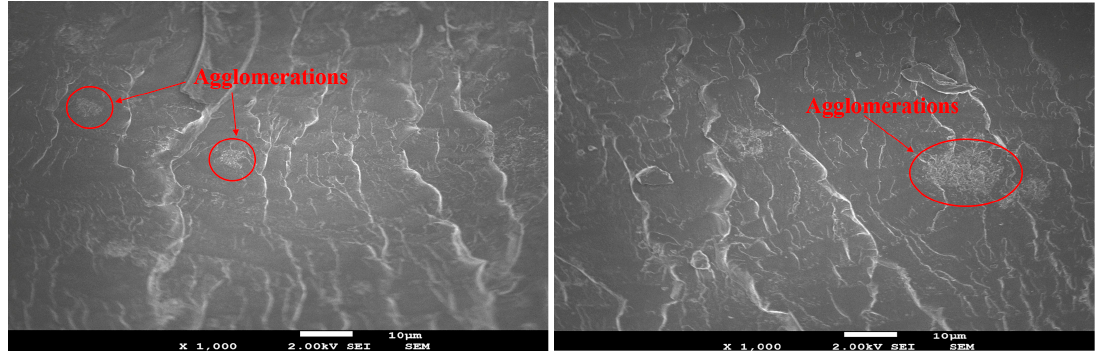
Figure 5. Agglomeration observed in the ( a ) 1.0 and ( b ) 3.0 wt.% composites (scale bar = 10 µ m).